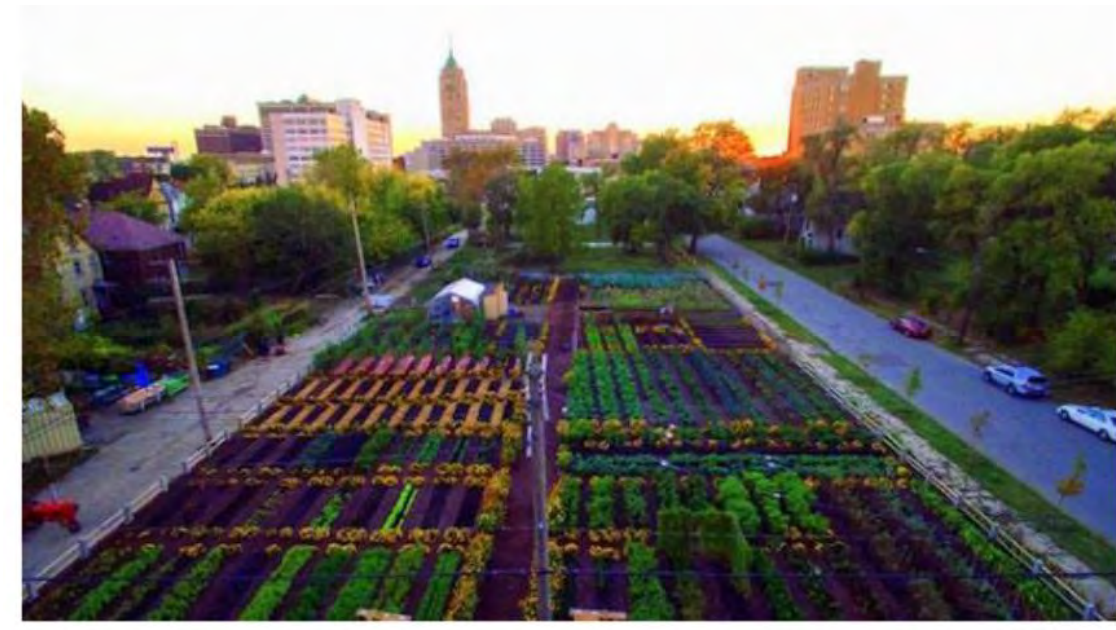
Figure 8. Detroit’s new agrihood (”Paste Magazine”, n.d.).